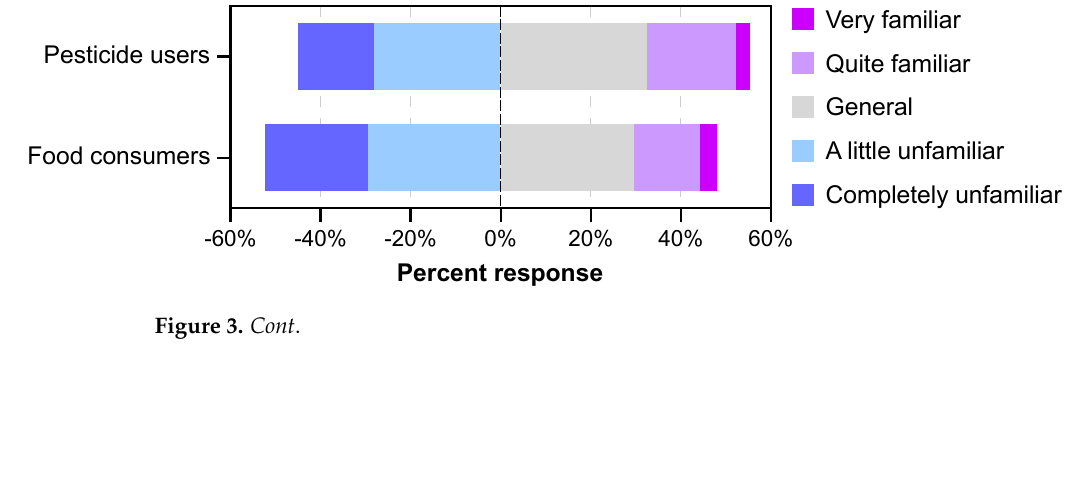
Figure 3. Comparison of public’s perspectives on nanopesticides between pesticide users (i.e., farm- ers) and food consumers (i.e., people from aquaculture and animal husbandry). Public responses when asked ( a ) “How familiar are you with nanopesticides?”; ( b ) “What is your attitude toward the future development of nanopesticides?”; ( c ) “Do you agree that the product label of nanopesticides must indicate that it contains nano-components?”; ( d ) “Do you trust that industries (manufactures